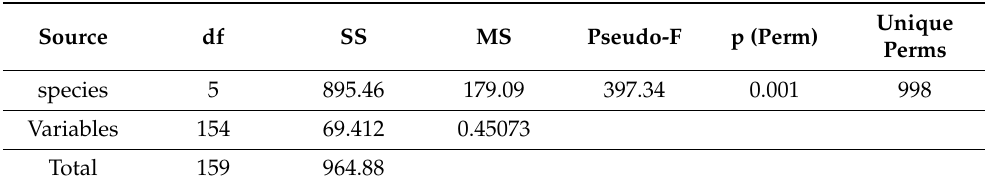
Table 5. Permutational analysis of variance (PERMANOVA) for sixteen morphological traits in different populations of Mylonchulus .